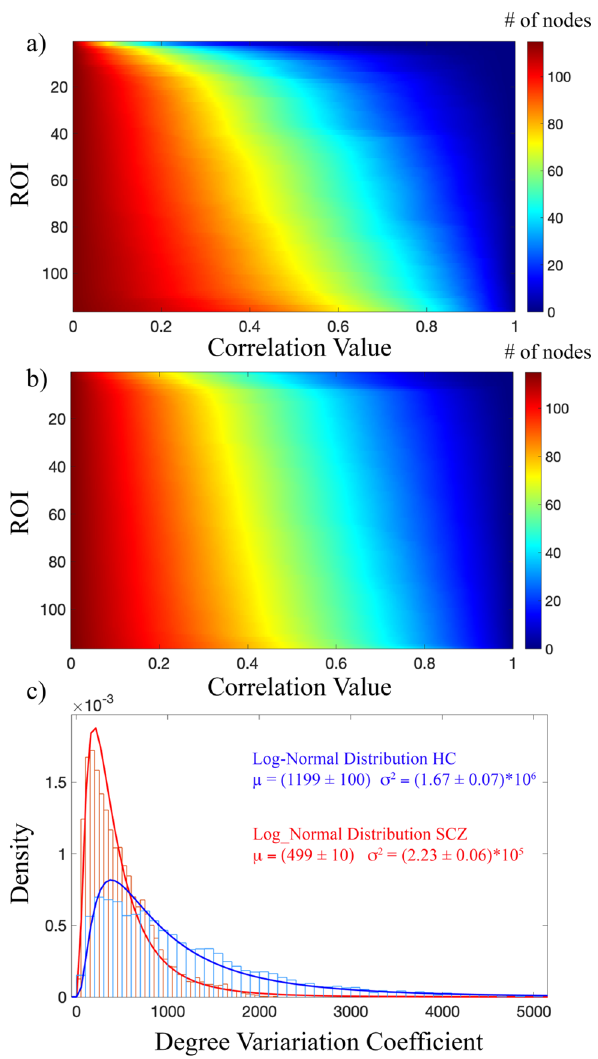
Figure 7. Percolation and node degree analysis. ( a ) Variation of the node degree averaged across subjects for HC. ( b ) Variation of the node degree averaged across subjects for SCZ, ( c ) density of the distribution of the Degree Variation Coefficients for HC (blue) and SCZ (red). Data were fitted to a log-normal distribution with mean μ and variance σ 2 . The curve fitting results are reported for both HC and SCZ with the errors of the